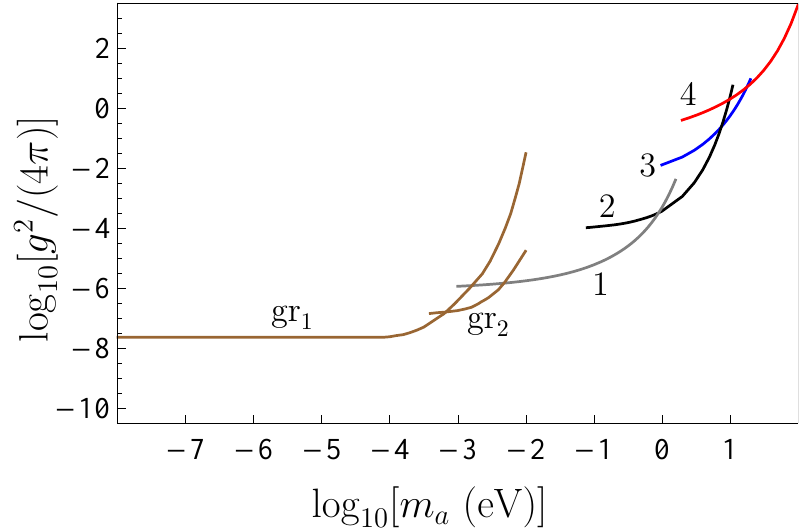
Figure 3. The strongest laboratory constraints on the coupling constant of axionlike particles to nucleons obtained from the Cavendish-type experiment (line labeled “gr 1 ”), from measuring the minimum forces of gravitational strength by means of torsion pendulum (line labeled “gr 2 ”), from the Casimir-less experiment (line 1), from measuring the Casimir pressure (line 2), lateral Casimir force (line 3), and the Casimir force at nanometer separations (line 4). The plane areas above the lines are excluded and below them are allowed by the measurement data.